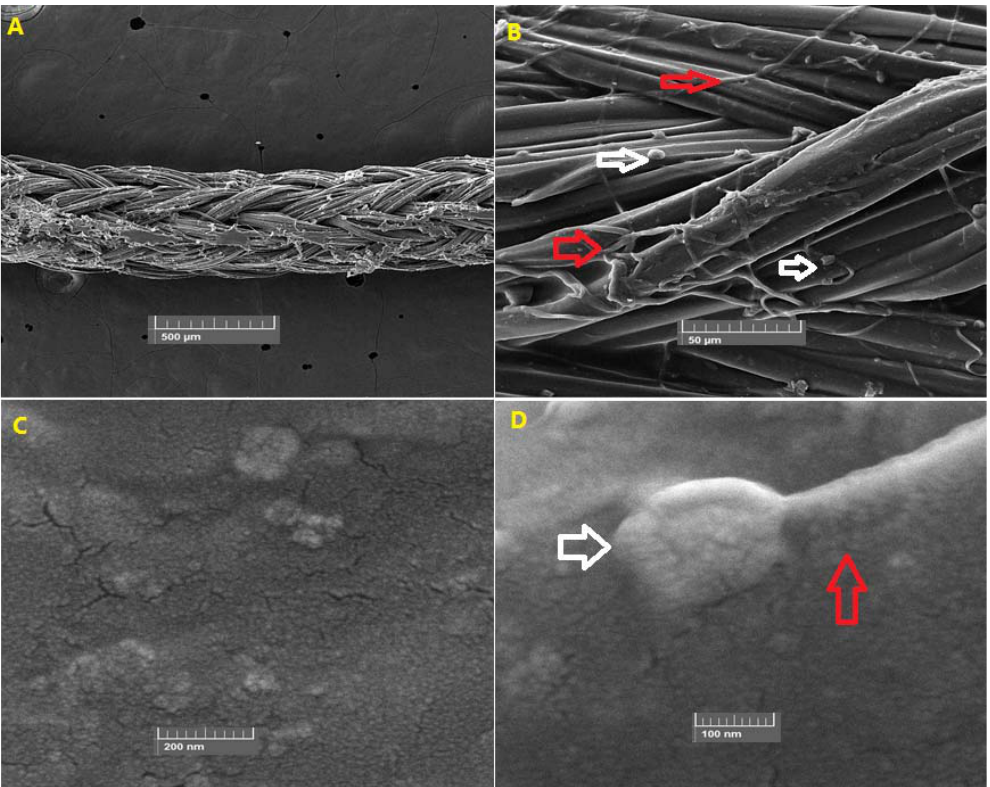
Fig. 1: Scanning electron microscopy (SEM) of CFX@PVA silk sutures with different magnifying scales. (Red arrows: PVA and white arrows: CFX)